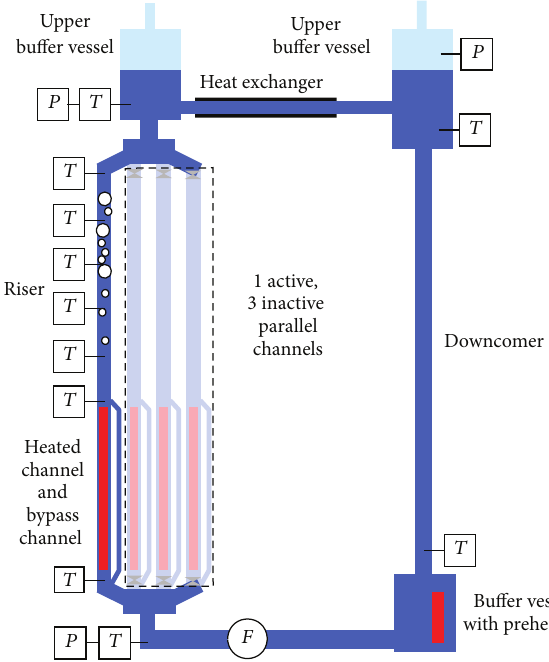
Figure 1: Scheme of the CIRCUS-IV test facility in the single channel